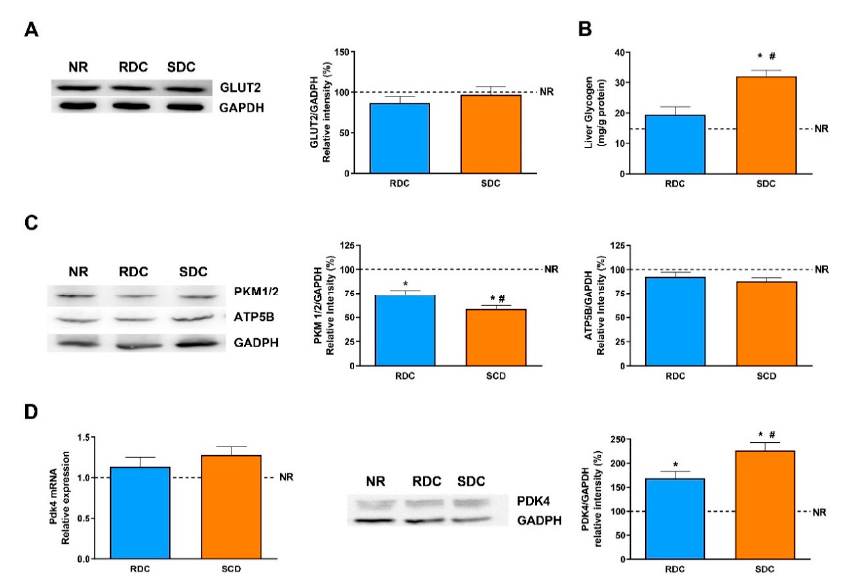
Figure 8. Liver glucose transporter, glycogen levels, and expression of key carbohydrate metabolism regulatory enzymes in the experimental groups. ( A ) Glucose transporter 2 (GLUT2), ( B ) glycogen content, ( C ) pyruvate kinase (PKM1 / 2) and (ATP synthase 5b subunit (ATP5b). ( D ) Pyruvate dehydrogenase kinase 4 (PDK4) mRNA and protein expression. NR group, not restricted; RDC group, refeeding with rapid digestible CHO diet; SDC group, refeeding with slow digestible CHO diet. * Significant difference with NR group, p < 0.05. # Significant difference with RDC group, p < 0.05.